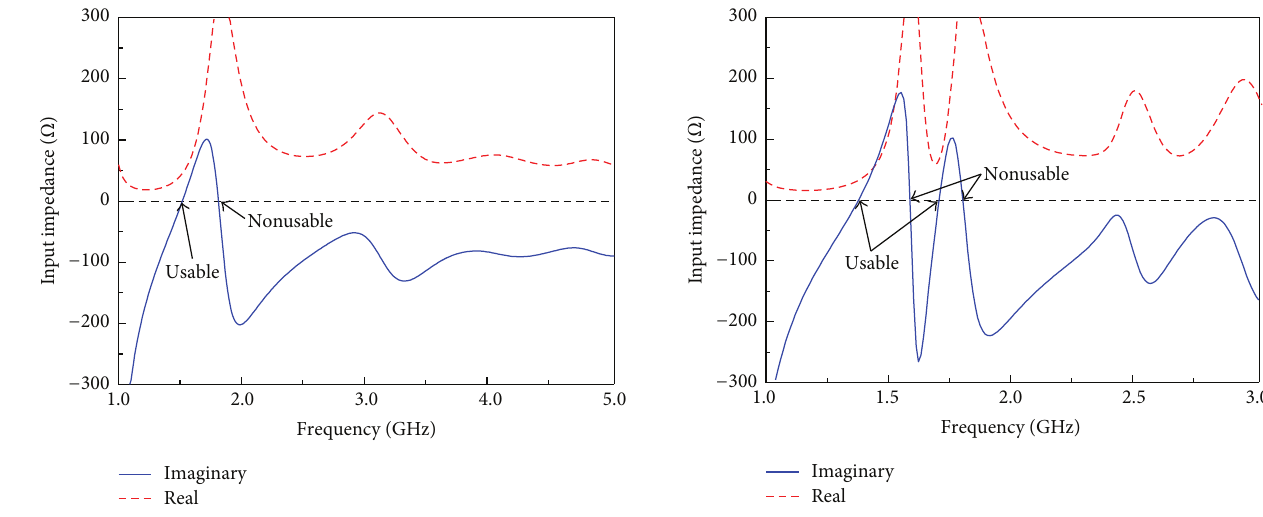
Figure 5: Simulated input impedance ( 𝑍 11 or 𝑍 22 ) of the ideal asymmetrical four-arm curl antenna ( 𝑛 1 = 𝑛 2 = 1.1 , 𝑛 3 = 𝑛 4 = 1